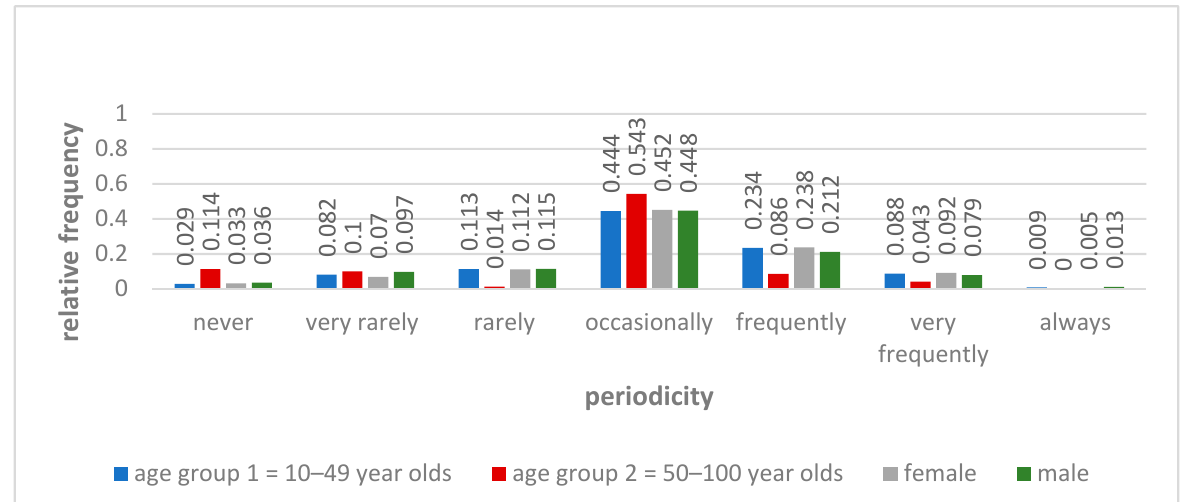
Figure 2. Following the VoD services’ algorithmically generated recommendations by age (N = 1258) and gender (N = 1253) (relative frequencies). Question: How often do you follow recommendations from video streaming services?